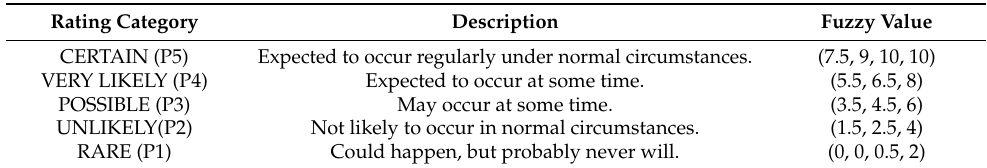
Table 3. Probability of scenario occurrence.